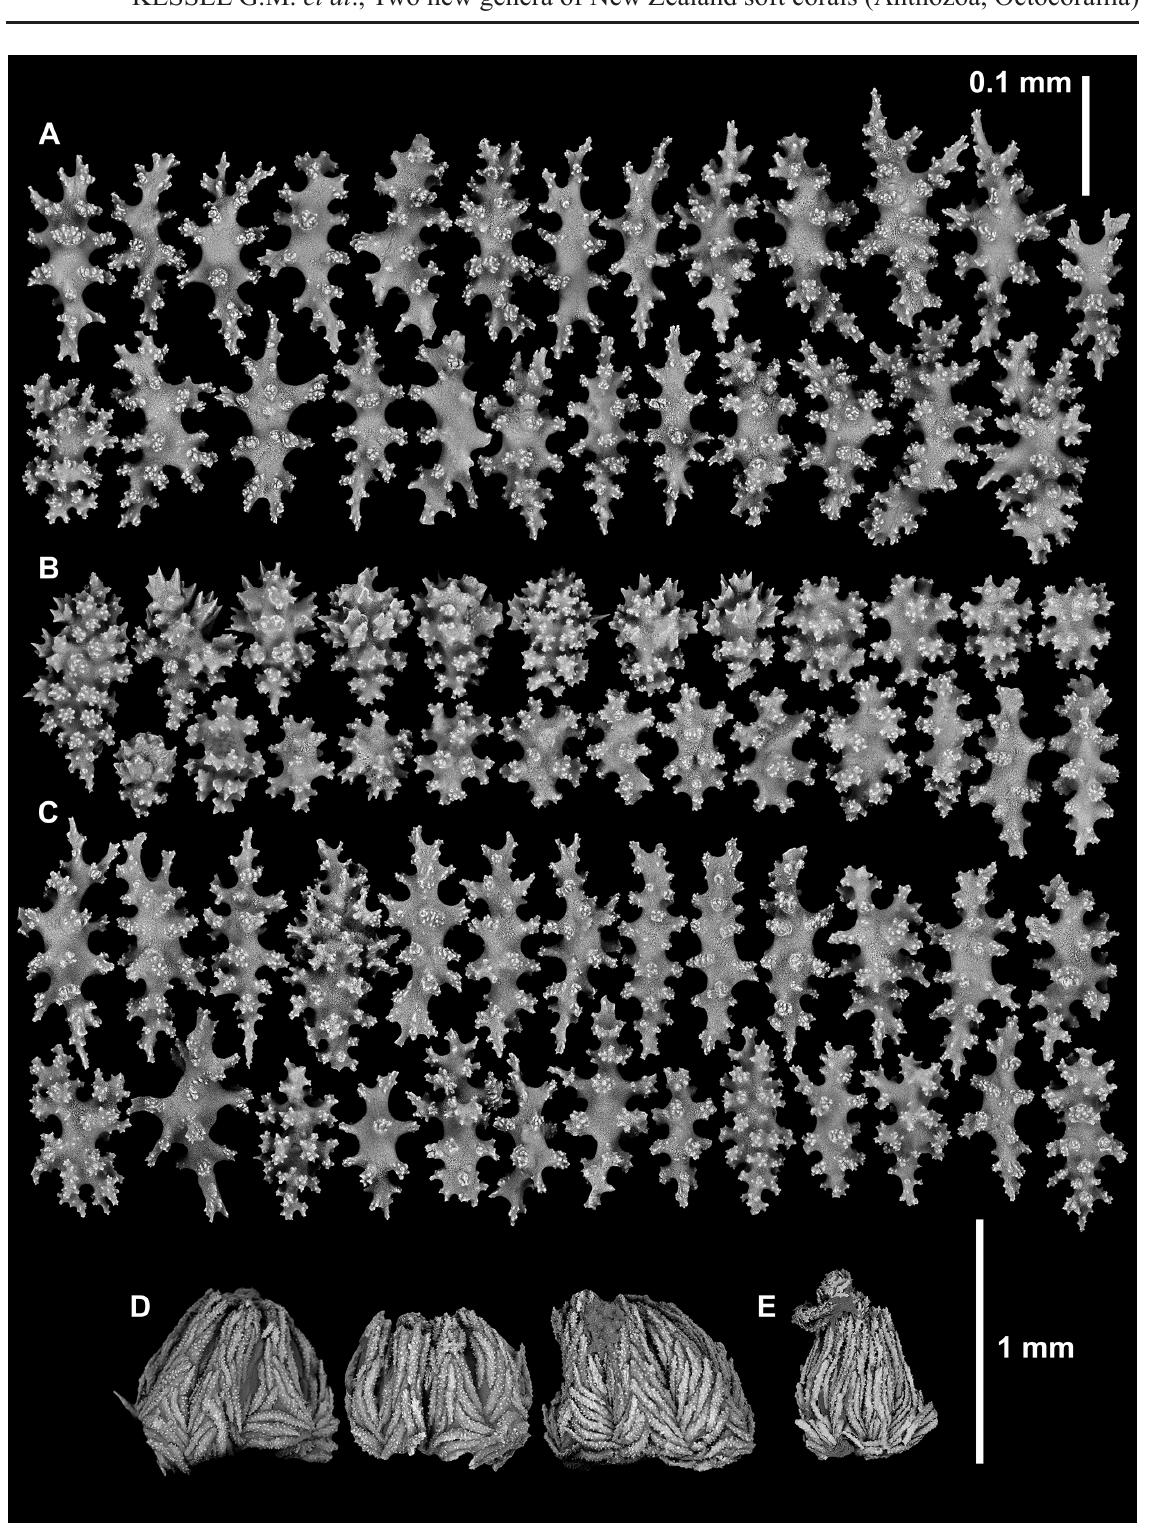
Fig. 26. A–D . Kotatea raekura gen. et sp. nov., holotype (NIWA 101537), SEMs of sclerites. A . Lobe interior. B . Base surface. C . Base interior. D . Polyps (in situ). — E . K. teorowai gen. et sp. nov., holotype (NIWA 27358), SEMs of sclerites, polyp (in